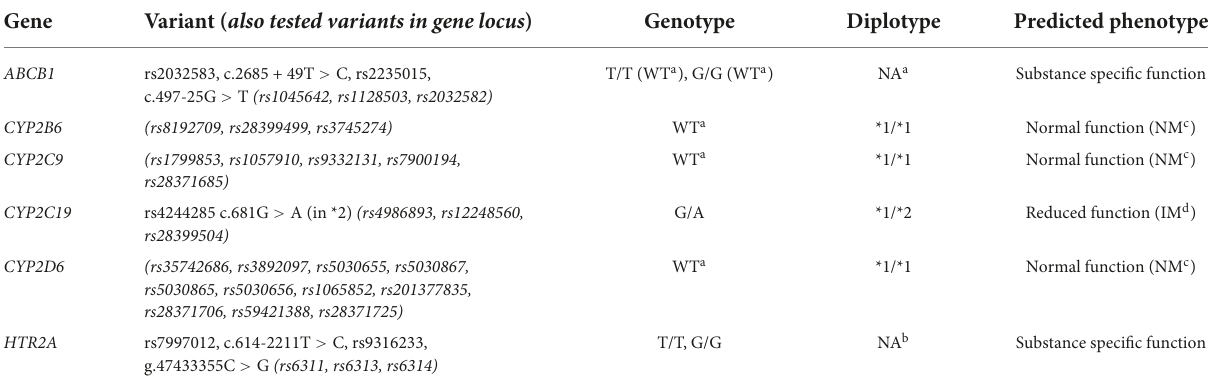
TABLE 1 Selected results of the panel pharmacogenotyping and phenotype